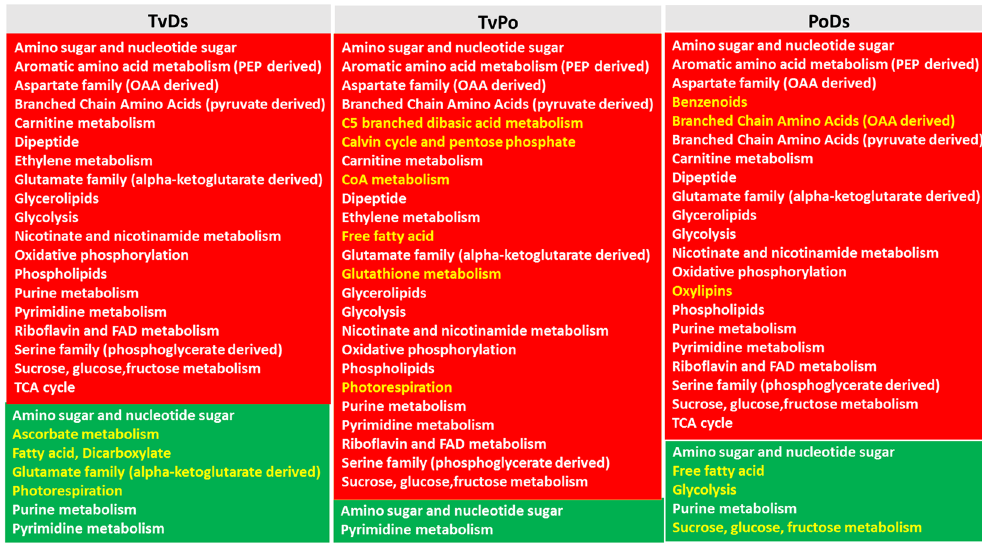
Figure 4. Synergistic changes in all three interaction zones relative to both isolates. Red arrow means increase, green arrow means